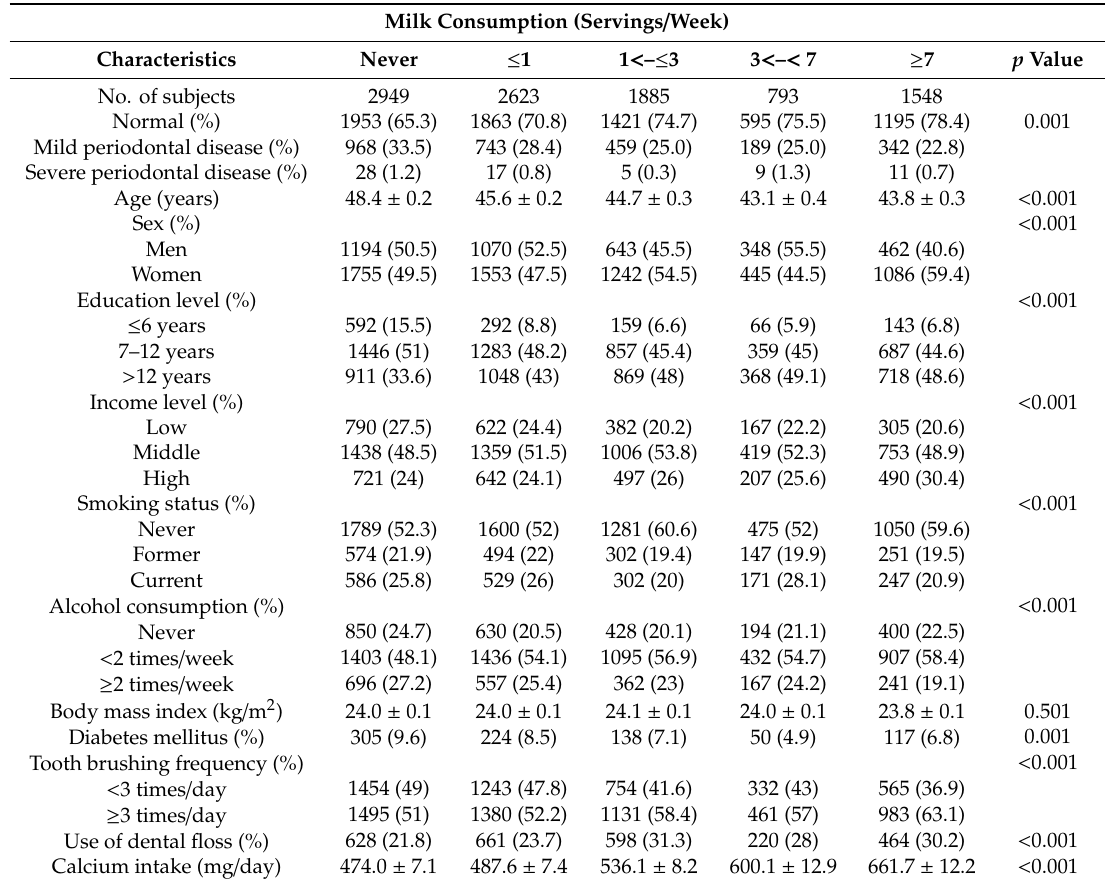
Table 3. General characteristics of participants according to milk consumption 1